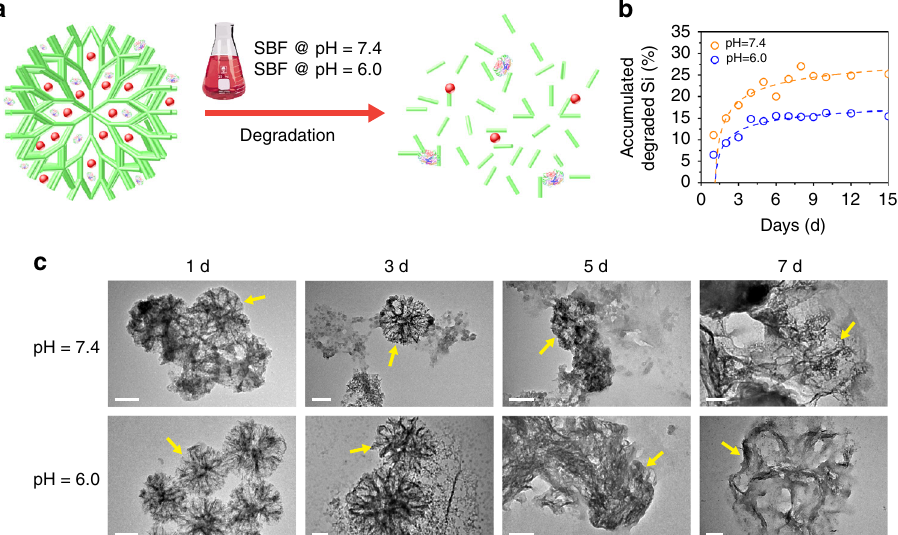
Fig. 5 Biodegradation behavior of GFD NCs. a Schematic illustration of biodegradation process of GFD NCs. b Accumulated concentrations of released Si- based biodegradation products in SBF under neutral (pH = 7.4) and acidic (pH = 6.0) conditions. c TEM images of GFD NCs after biodegradation in neutral (pH = 7.4) and acidic (pH = 6.0) SBFs for varied durations: 1, 3, 5, and 7 days. Scale bar : 100